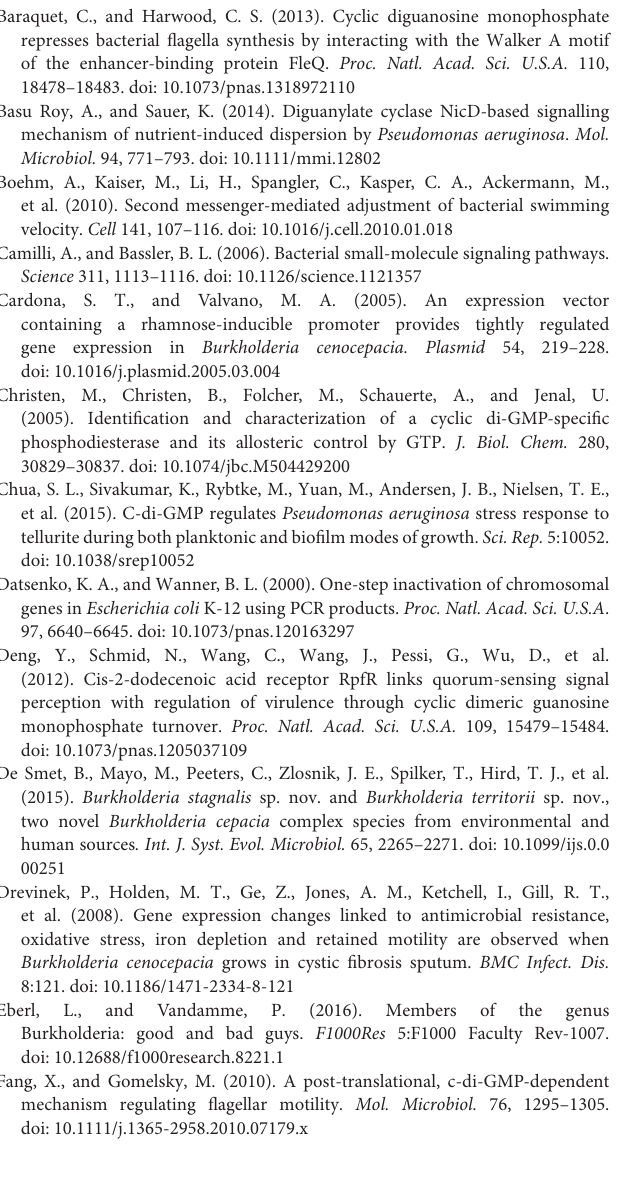
Figurski, D. H., and Helinski, D. R. (1979). Replication of an origin-containing derivative of plasmid RK2 dependent on a plasmid function provided in